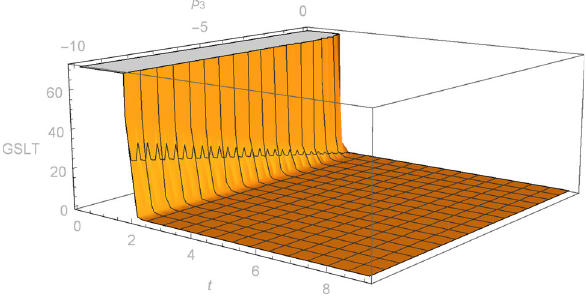
Fig. 5 The graphical illustration of GSLT versus β 3 for the second model. Herein, we set β 1 = . 02, β 2 = 0 . 3 and σ =